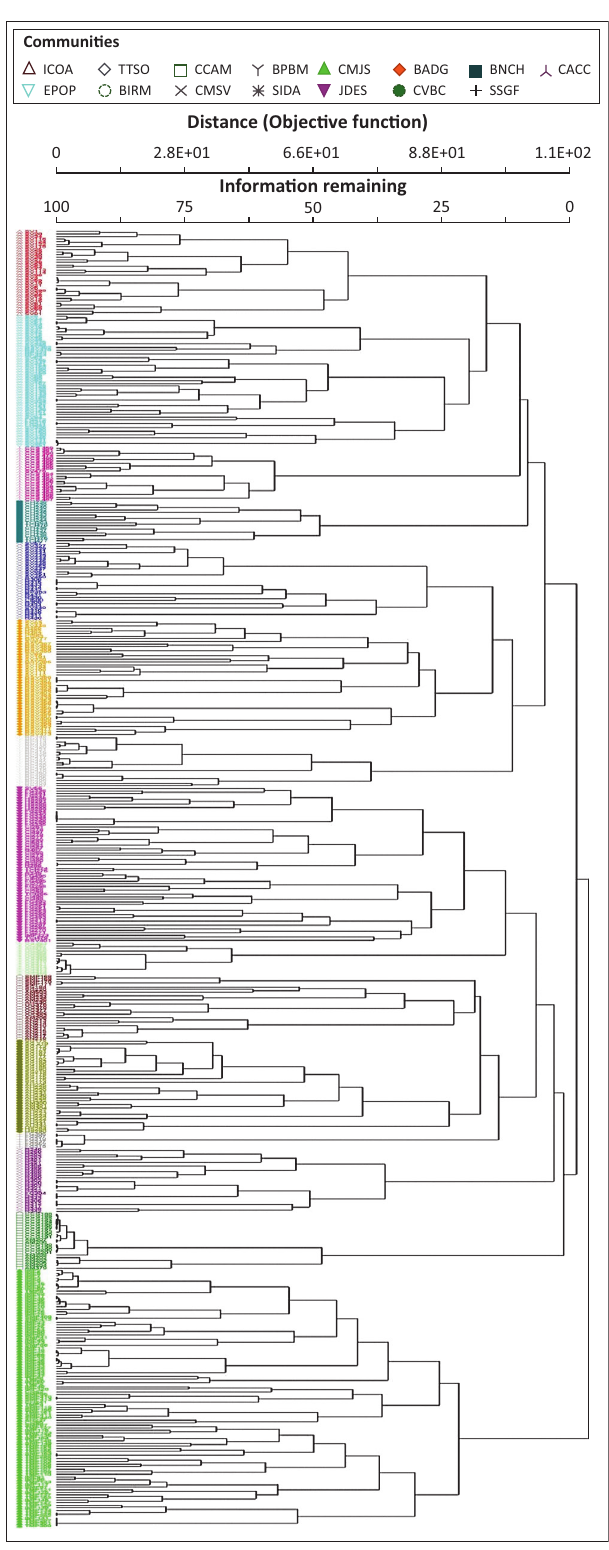
FIGURE 1-A1: Cluster analysis showing the 15 plant communities identified in the Savuti-Mababe-Linyanti ecosystem, northern